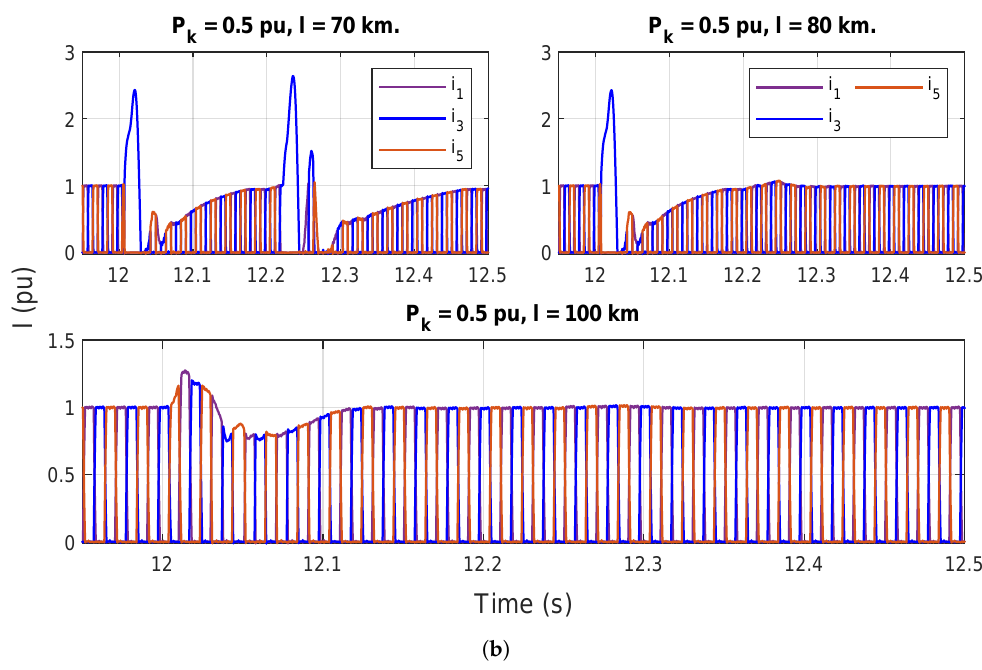
Figure 1. Thyristors currents i 1 , i 3 and i 5 as a function of VSC power dispatch and tie line length: ( a ) Thyristors currents as function of VSC power dispatch. ( b ) Thyristors currents as function of VSC-LCC tie line length.